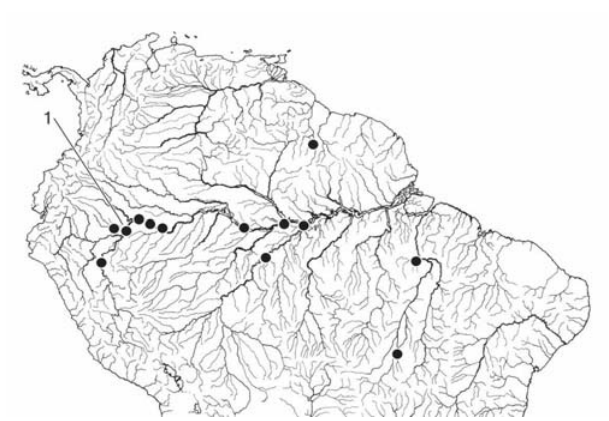
Fig. 5. Map of central and northern South America showing distribution of Auchenipterichthys coracoideus (1 = holo- type locality; some symbols represent more than one locality or lot